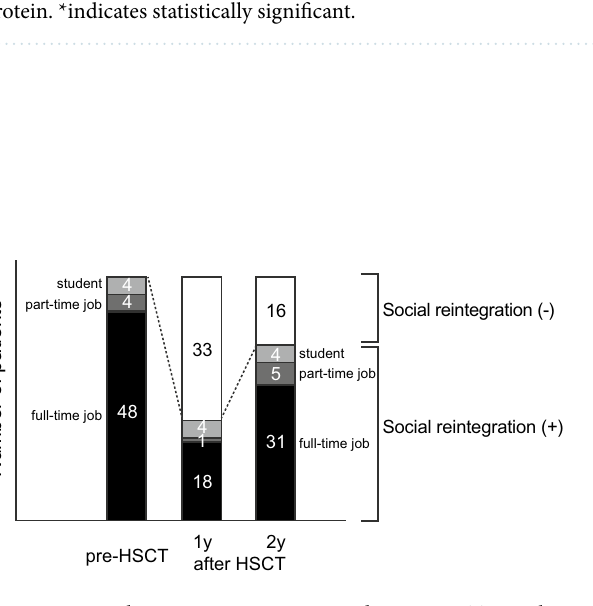
Figure 2. Social integration status pre- and post- HSCT. Social status pre-HSCT and at 1 year and 2 years post- HSCT are shown. The number denotes the number of patients in each